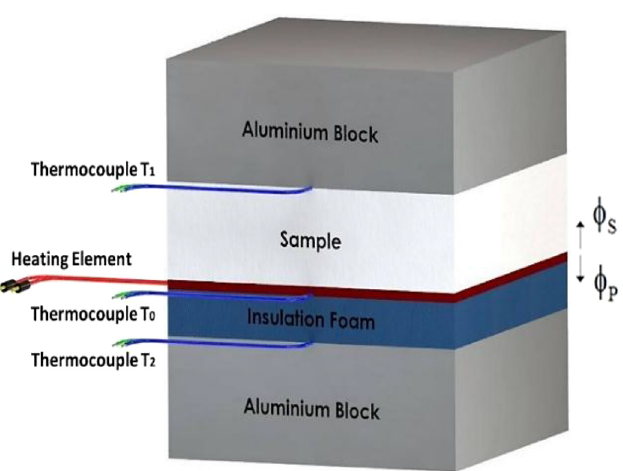
Fig. 2. Experimental device of hot plate method in a steady-state